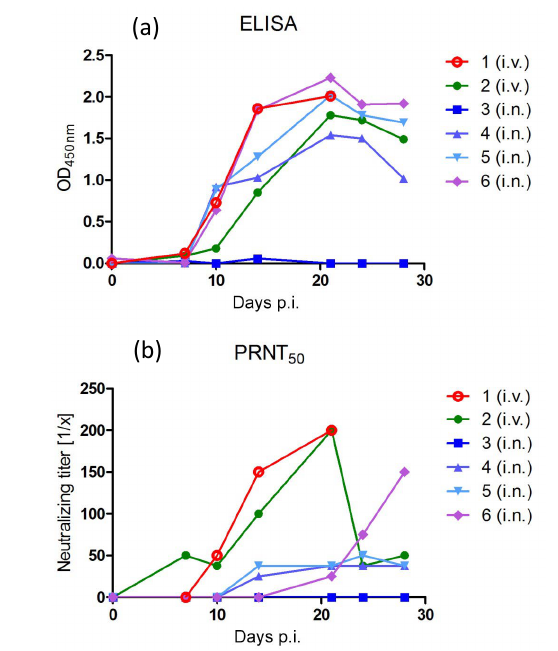
Figure 3. Detection of calpox-virus-specific antibodies in plasma of infected animals. At different points in time post-infection (see Sect. 2.1), whole blood was collected and plasma was prepared.